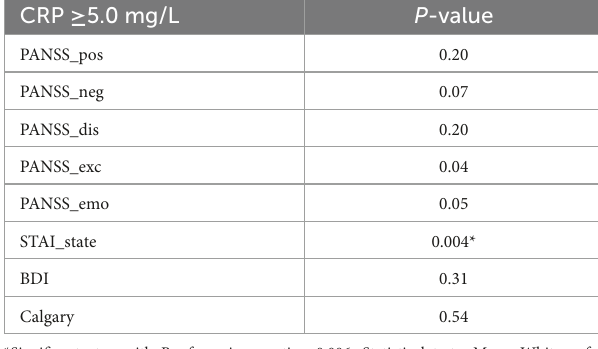
TABLE 1a Statistical association between elevated C-reactive protein levels at admission and the patients’ psychological state at admission.